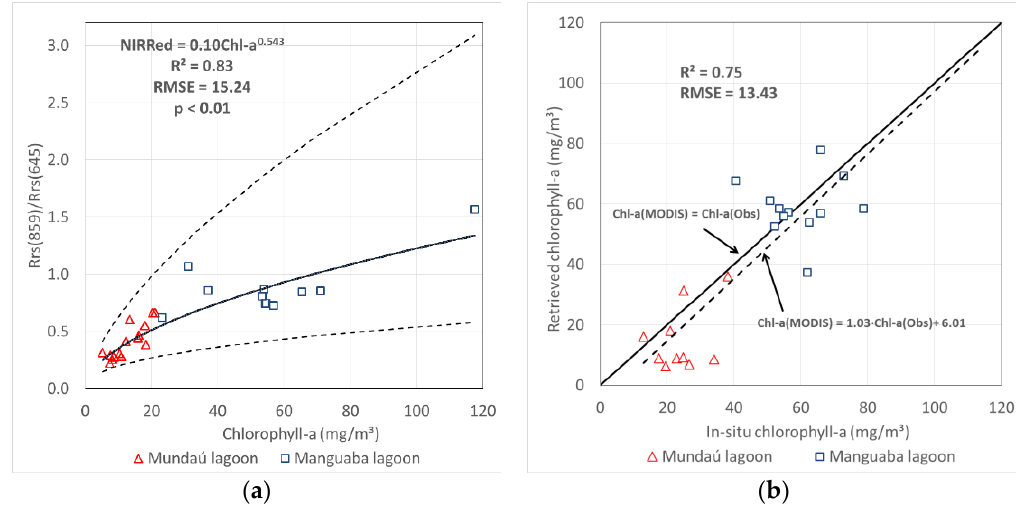
Figure 2. Near infrared-red (NIR-Red) band ratio algorithm to estimate Chl-a in MMELS: ( a ) semi- empirical potential model using calibration data. The dashed lines represent 95% confidence lines of the linear regression; and ( b ) observed versus retrieved values of Chl-a using data entirely independent of the calibration data. The dashed line is a linear regression of data points and the solid line represents the discrepancy ratio between observed and predicted values.